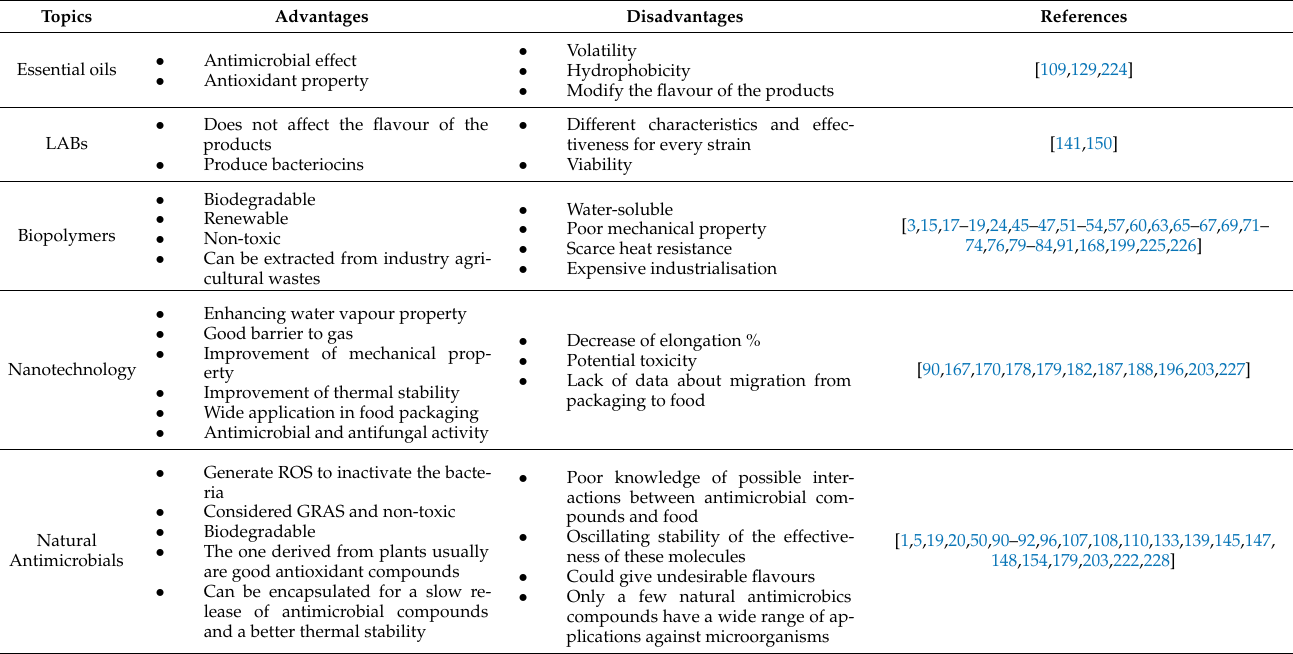
Table 6. Advantages and disadvantages of essential oils, LABs, biopolymers, nanotechnology, and natural